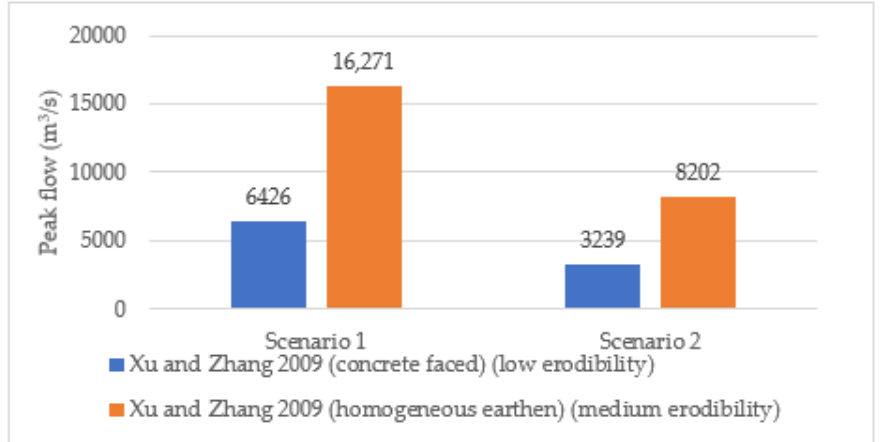
Figure 15. Comparison of peak discharges from Xu and Zhang’s 2009 [26] empirical equation for different dam types and erodibilities.